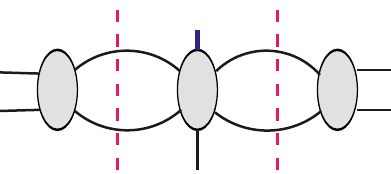
Figure 1 . A reducible cut. The blue line is the ϕ Q operator. Each solid blob represents a tree amplitude (or tree form factor), while a blob with several holes represents a multiloop amplitude (or multiloop form factor).